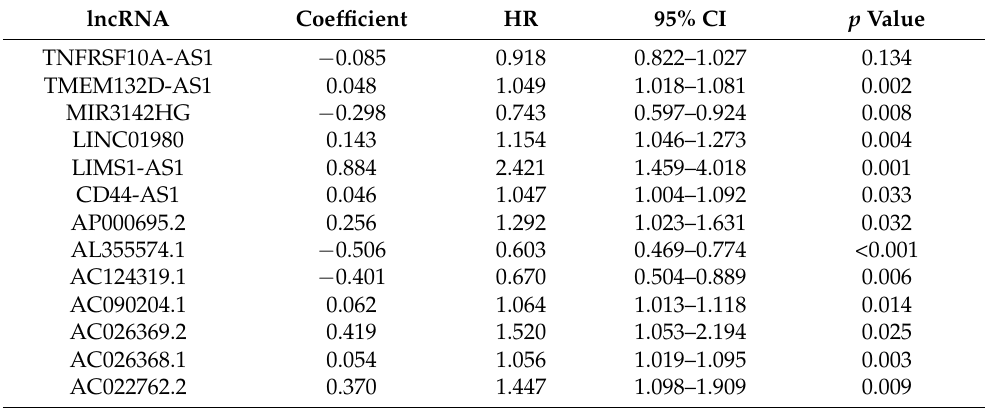
Table 1. LncRNAs of the